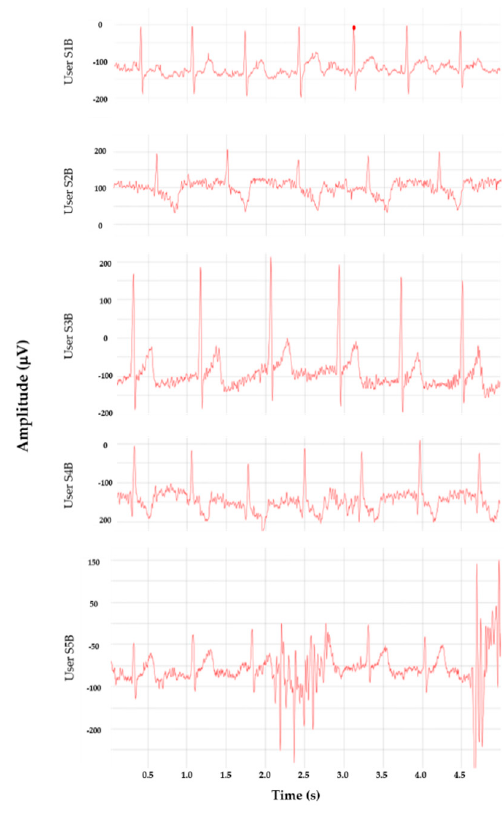
Figure 23. Arm-ECG signals from users working in the laboratory. The signal recorded from User No. 5 was strongly contaminated by muscular artifacts making it unusable for the rest of the test. Table 10. R-peak detection and SNR calculation only for four of the subjects who restricted their physical activity to a low level, as requested (TP is the number of true R-peaks